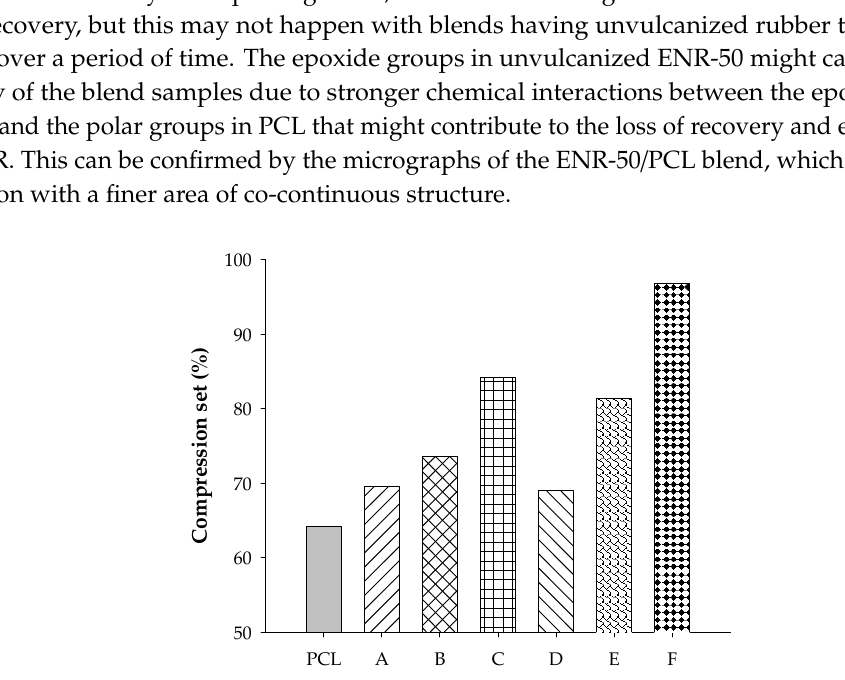
Figure 5. Hardness of PCL, A = STR5L/PCL at 40/60, B = STR5L/PCL at 50/50, C = STR5L/PCL at 60/40, D = ENR-50/PCL at 40/60, E = ENR-50/PCL at 50/50, and F = ENR-50/PCL at 60/40.